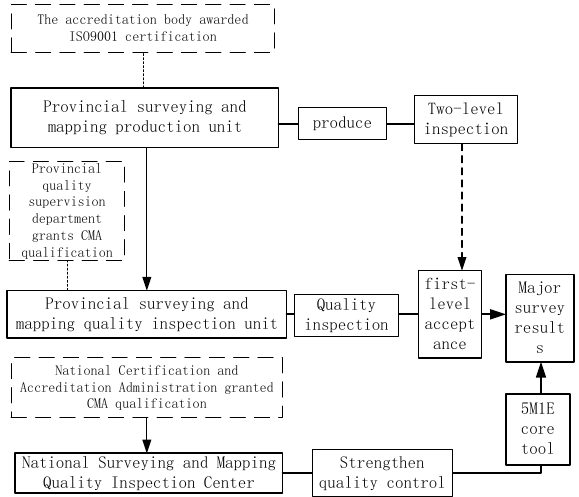
Figure 1. Flow chart of production and quality inspection